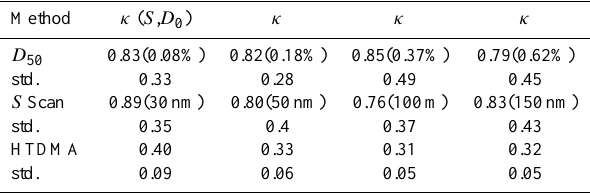
Table 2. Average κ values and standard deviations (std.) from the project, computed assuming the surface tension is that of pure water.